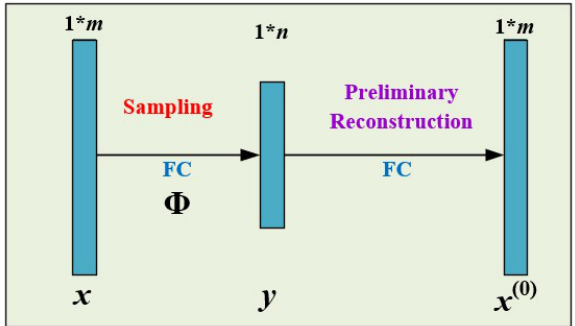
Figure 2. Structure diagram of a fully connected layer sampling and preliminary reconstruction network.